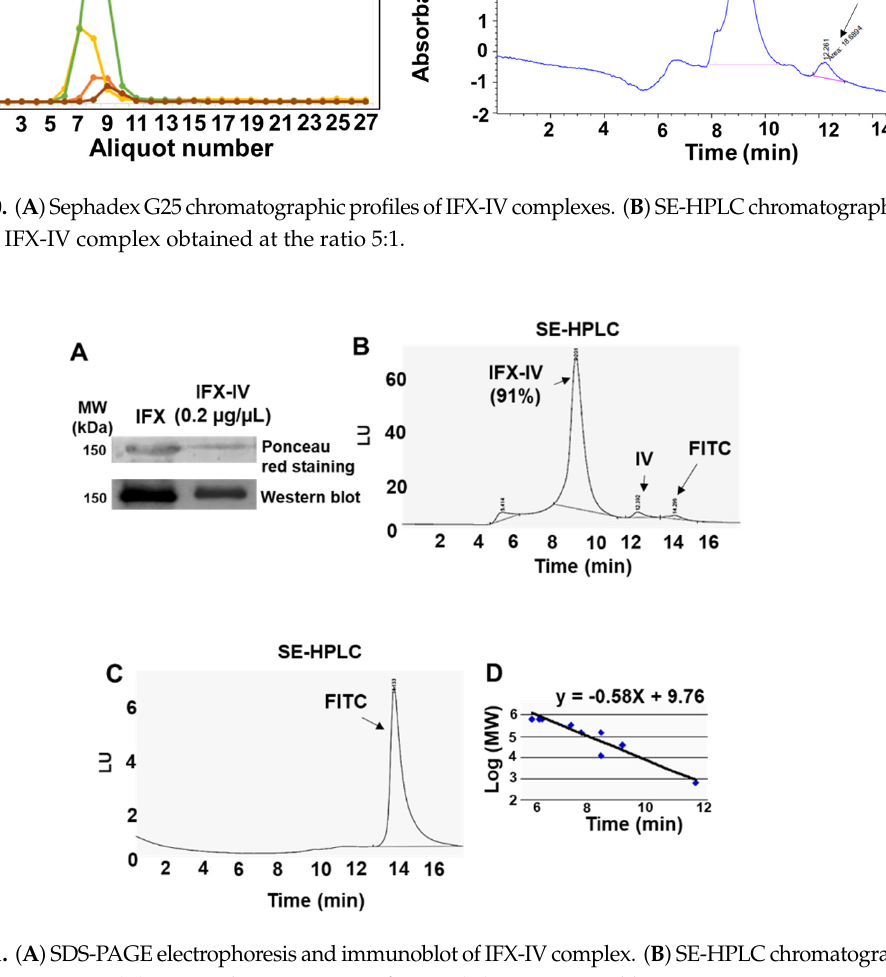
Figure 11. ( A ) SDS-PAGE electrophoresis and immunoblot of IFX-IV complex. ( B ) SE-HPLC chromatogram of IFX-IV conjugate. ( C ) HPLC chromatogram of FITC. ( D ) SE-HPLC calibration curve.